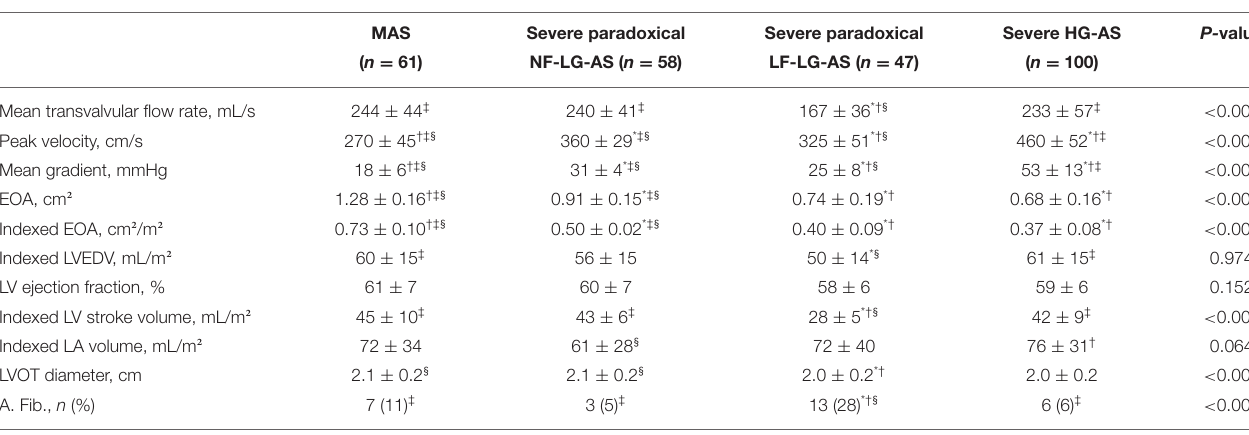
TABLE 2 | Baseline echocardiographic